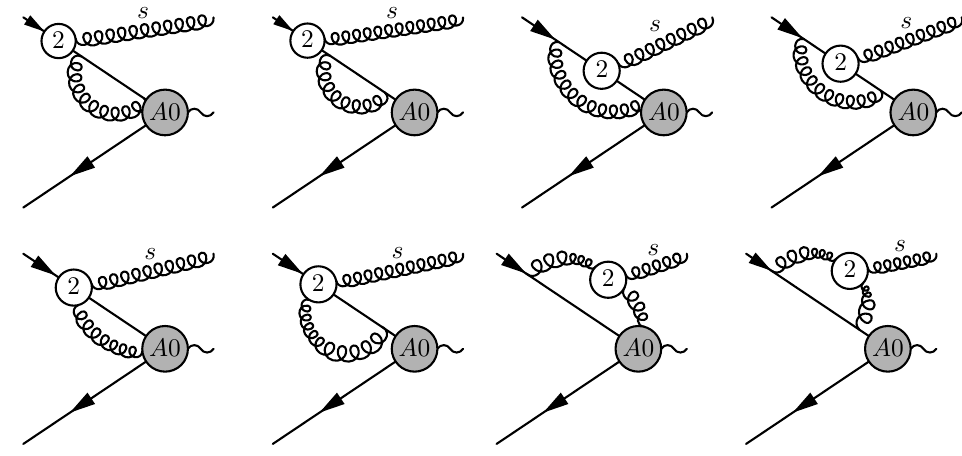
Figure 8 . One-loop collinear diagrams with one soft gluon emission. Only the LP current, A 0, is used here. Power suppression is provided by the time-ordered product insertion of terms. The collinear gluon in the loop attaches either to the collinear quark or the collinear